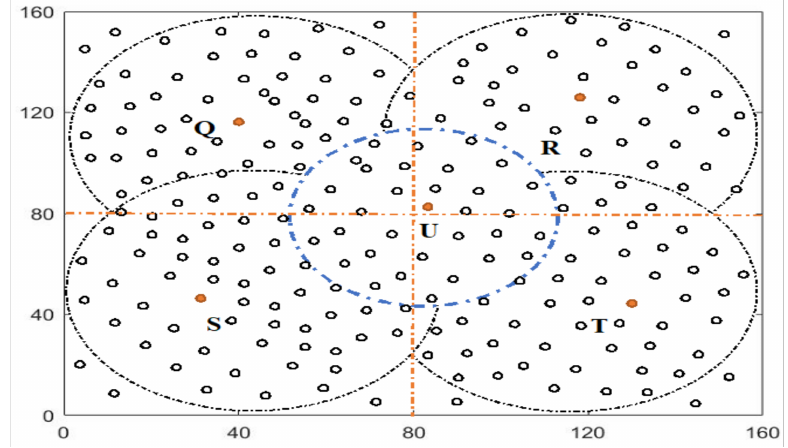
Figure 4. Network partition based on